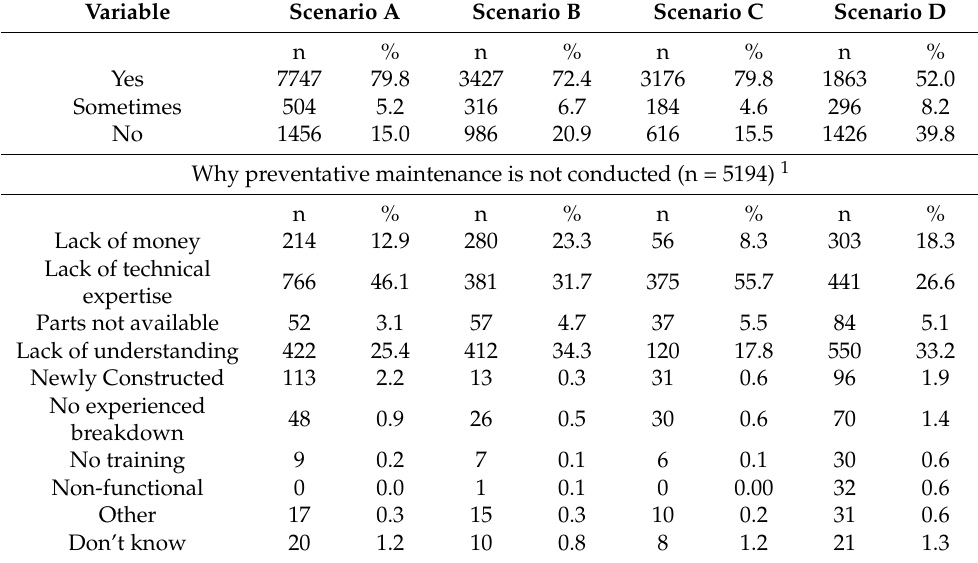
Table 1. Preventative maintenance conducted in each scenario (n = 21,997): Yes = preventative maintenance was conducted, No = preventative maintenance was not conducted, Sometimes = no predictable maintenance